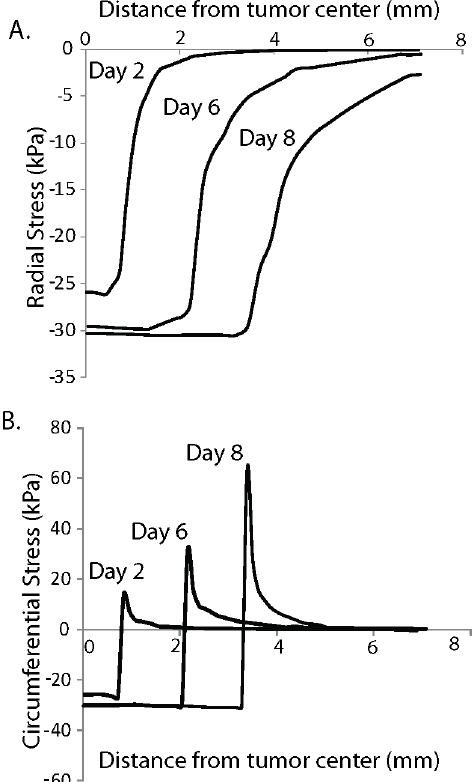
Figure 4. Spatial profile of solid stress. The A) radial and B) circumferential solid stress in the tumor and the surrounding normal tissue are presented at three different time points. Solid stress is compressive and uniform in the tumor interior, while at the interface with the normal tissue radial stress diminishes and circumferential stress turns steeply to tensile.